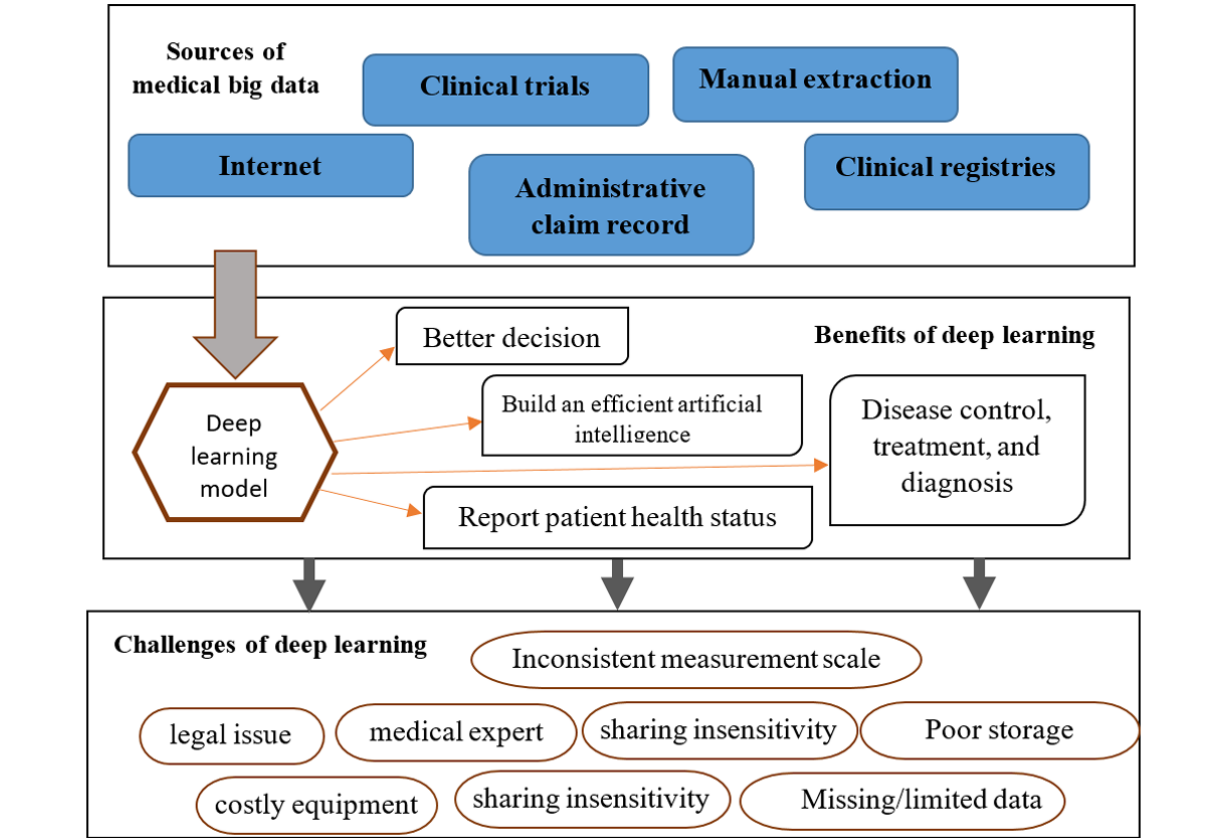
Figure 18. Overview of external challenges in acquiring and analyzing medical big